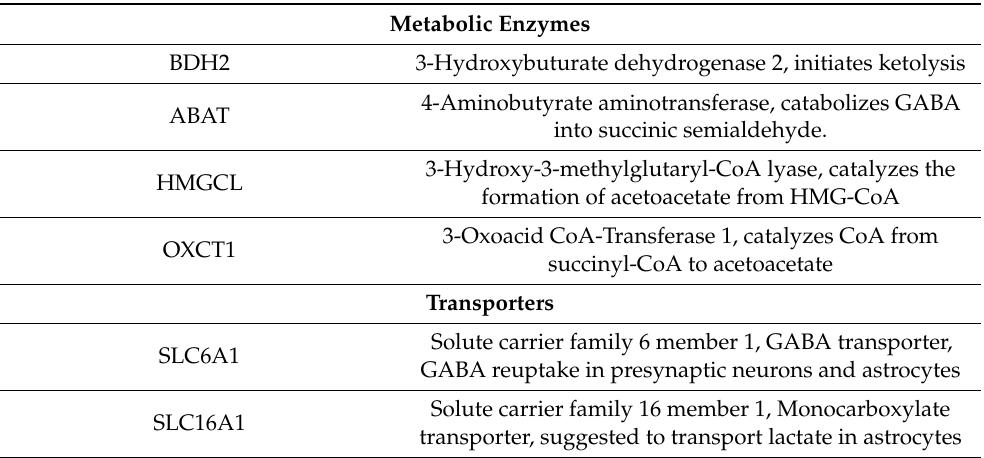
Table 1. Metabolic enzymes and transporters considered for qPCR